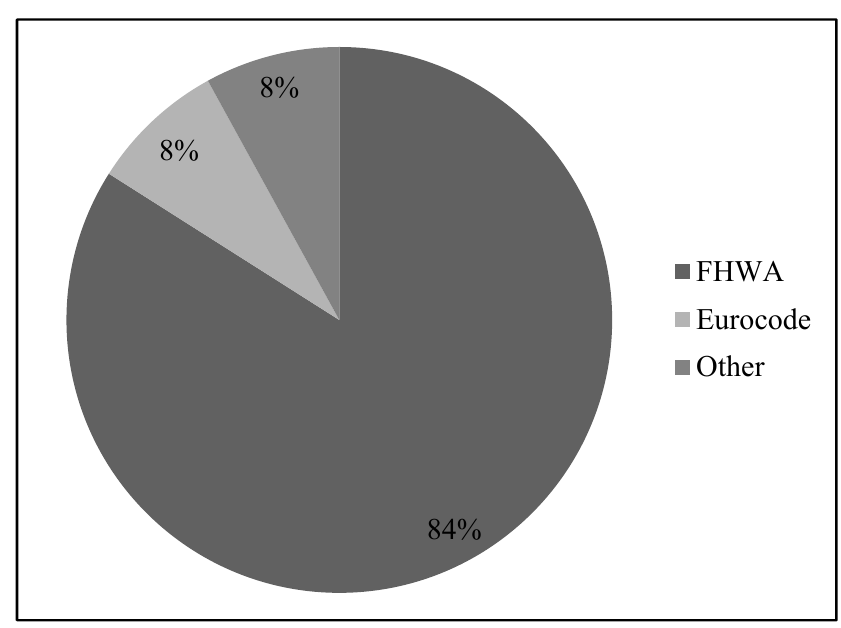
Figure 3. Recommended Design Methods.